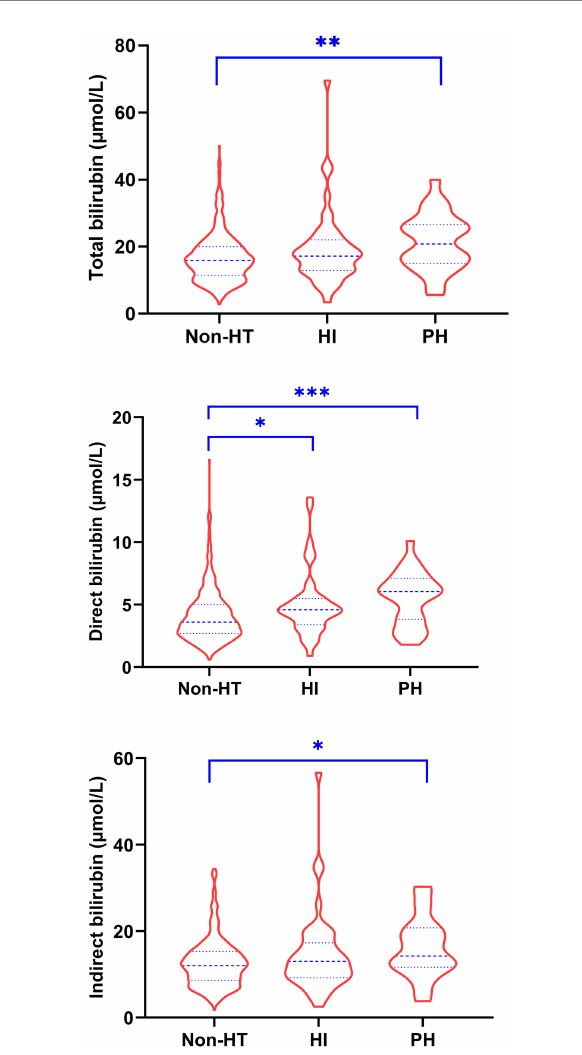
FIGURE 1 Comparison of serum bilirubin levels in patients without HT and with HI and PH. HI, hemorrhagic infarction; HT, hemorrhagic transformation; PH, parenchymal hemorrhage. * p < 0.05, ** p < 0.01, *** p <